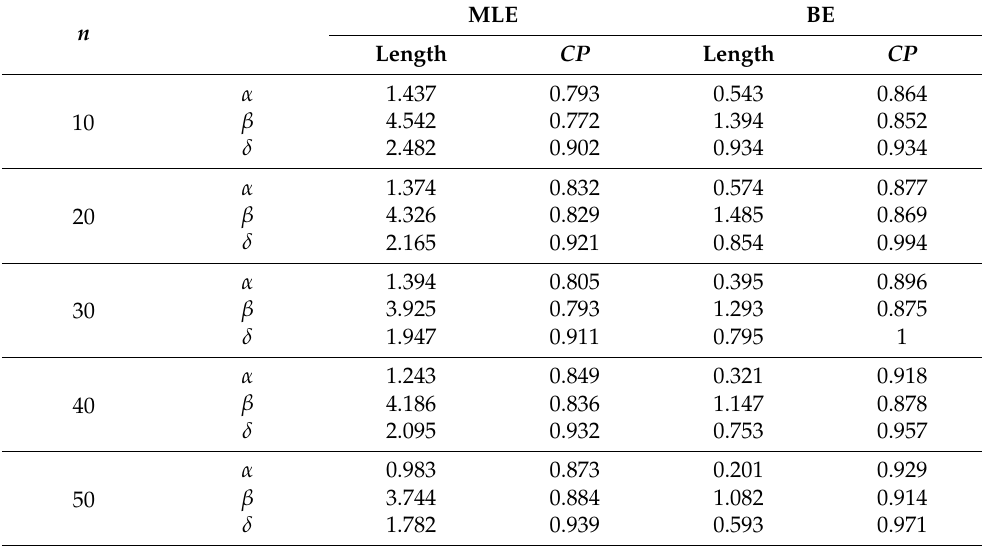
= 0.58, b = 0.93, a = 0.28, b = 0.66, and 2 2 1 1